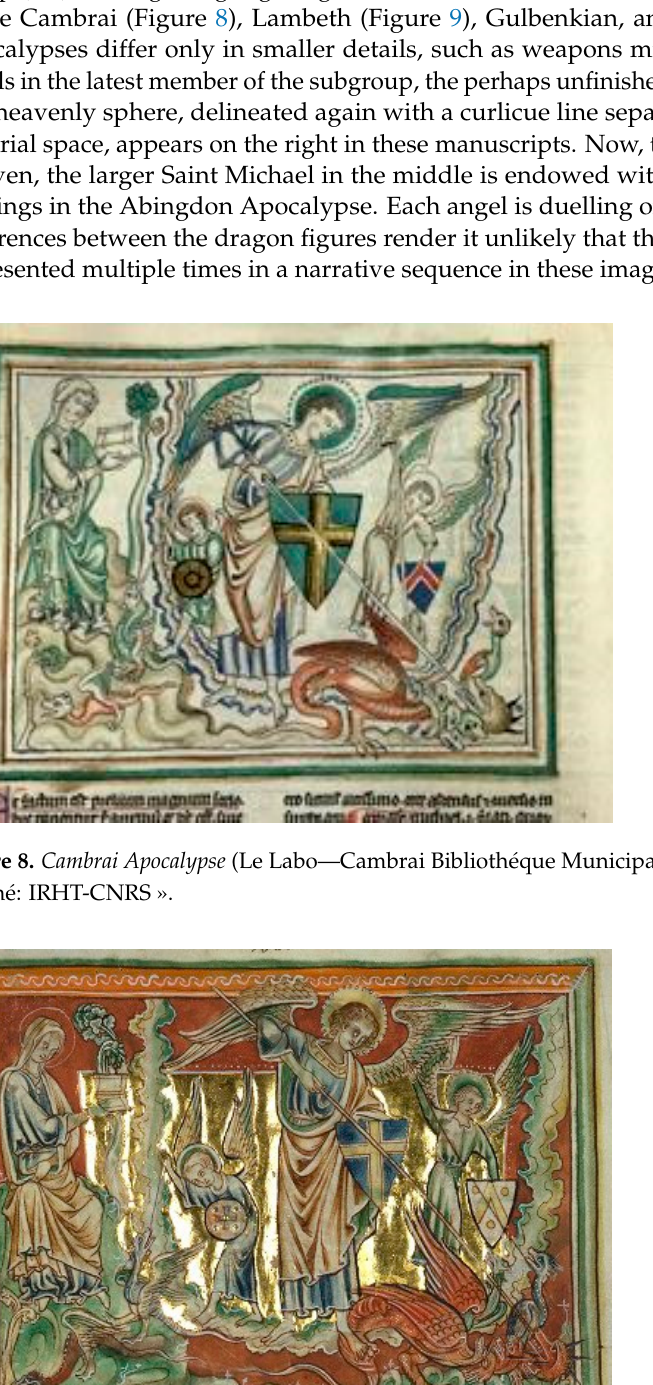
Figure 10. Abingdon Apocalypse (© British Library Board MS Add. 42555). Fol. 66v, c. 1270–75. Every single dragon is depicted outside Heaven. Similarly to the Tanner Apoca- lypse, Satan has already fallen in these images, and victory has been achieved. The texts accompanying the images also merge the two scenes as the manuscripts quote Revela- tions 12:7-12 and the relevant section of the Berengaudus commentary. Outside Heaven, the fallen dragons share the space of a woman sitting under a tree and reading a book on the far left, who shows little concern for the heated battle. These compositions, therefore, also fuse the War in Heaven and Fall of Satan with the Woman in the Wilderness scene, immediately preceding the War in Heaven episode in Revelations. The third subgroup of images focusing on the result of the battle (3.3) closes the present iconographical overview with the Douce Apocalypse (Figure 11) and BNF 10474 (Figure 12). Both manuscripts delineate the heavenly sphere with a particularly well-developed curlicue borderline flourishing in multiple layers in the centre of the composition. Once again, three angels appear fighting, with the larger Archangel situated in the middle; but neither image features subsidiary figures besides the participants of the battle. The angels’ sinister opponents nonetheless differ in the two manuscripts.